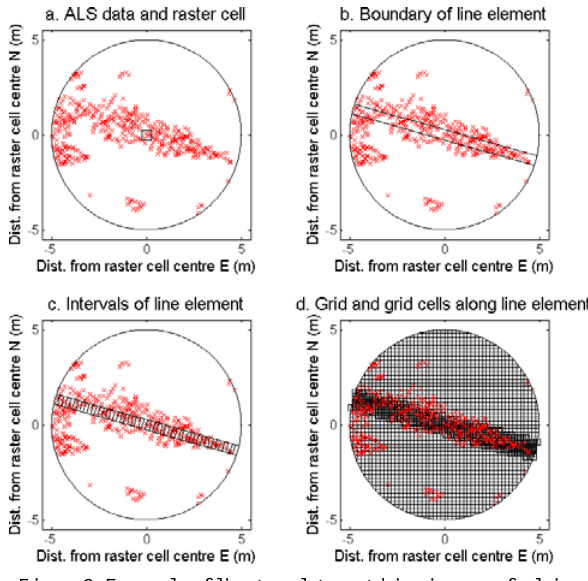
Figure 2. Example of line template matching in case of a lying tree stem measured in field. ALS data between ≥0.2 m and ≤1.0 m above the DTM are shown in red.